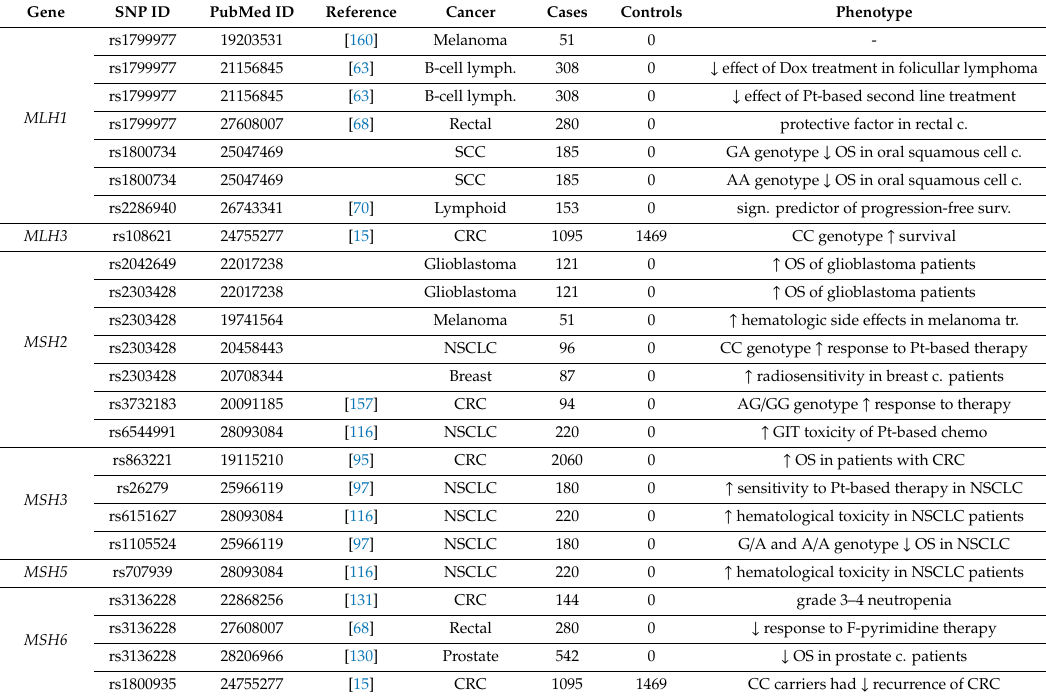
Table 3. The overview of SNPs studied for their role in the therapy of various types of